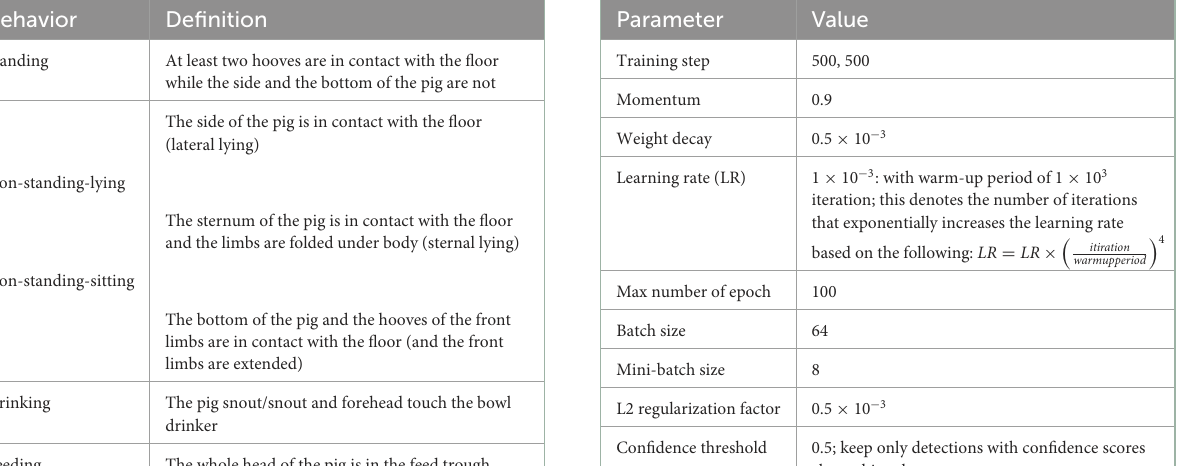
TABLE 1 Behavior and posture categories recorded in the dataset and their definitions. Behavior